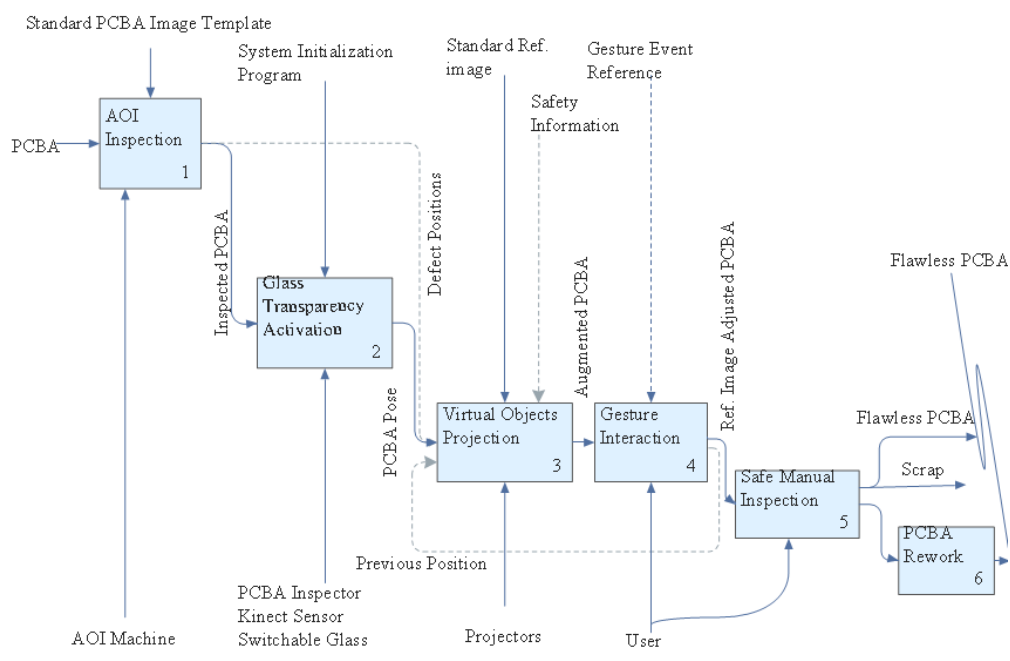
Figure 11. Implemented System Flowchart.